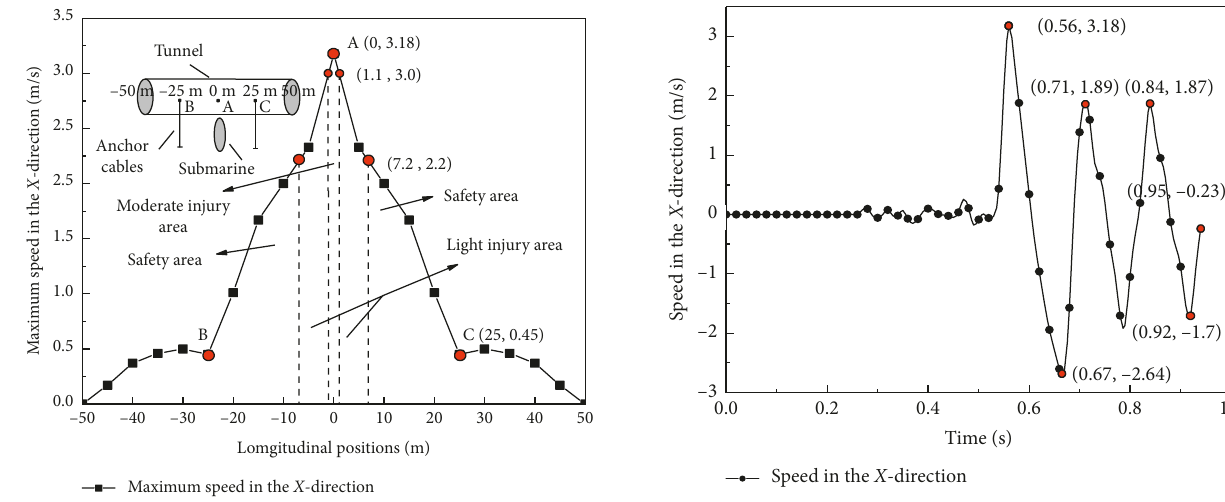
Figure 10: Maximum X -direction speed at different longitudinal positions.